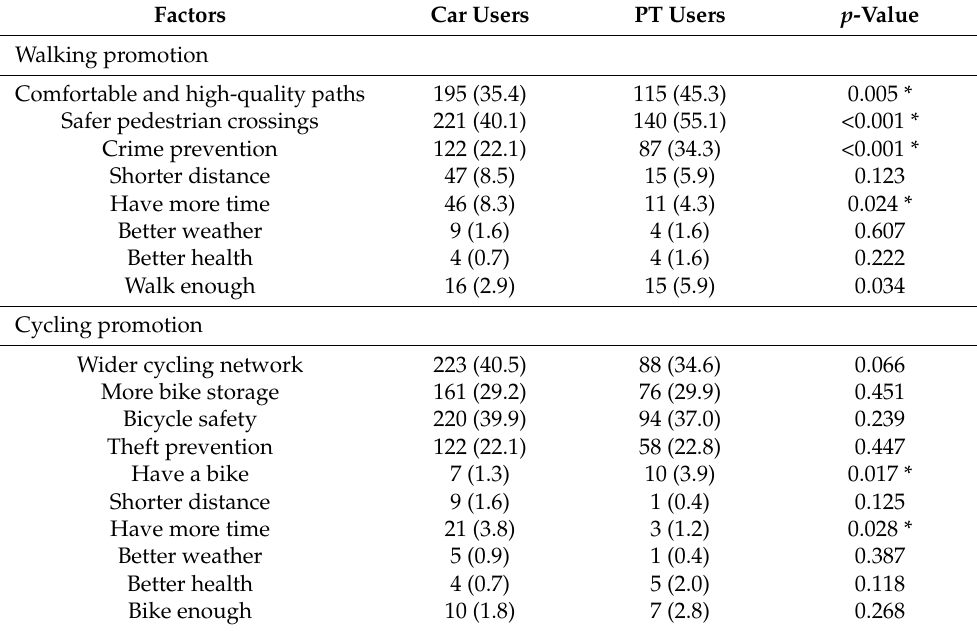
Table 3. Factors that promote walking and cycling among car and PT